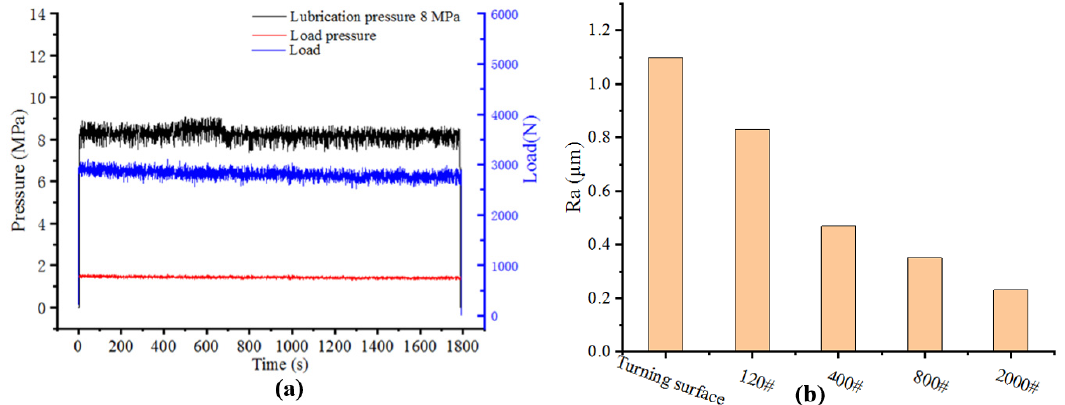
Figure 10. ( a ) The load curve and lubrication pressure of 316L–PTFE friction pair; ( b ) the average roughness ( R a ) of polished 316L surface with various abrasive papers.